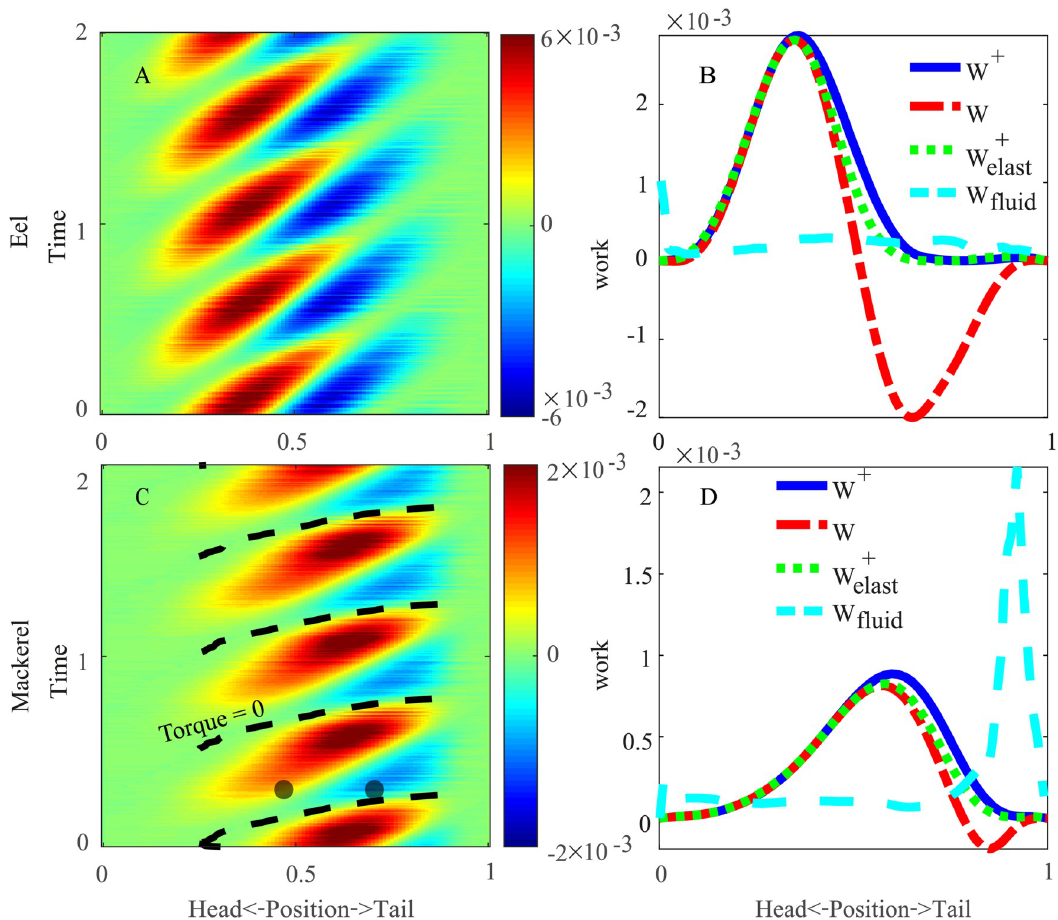
Fig 5. Internal power ( P ( s , t )) distribution for the eel (A) and the mackerel (C) and the work done over a cycle by muscles T along the bodies of the eel (B) and the mackerel (D). The dashed line in (C) indicates the zero-crossing of the torque in the mackerel (Fig 4B). The two black dots in (C) indicate an example time instant when two points on the body have the opposite sign of power but the same sign of torque. The solid blue lines in (B & D) represent the work by integrating only the positive values in (A & C), and the dashed-dotted red lines represent the work ( W ) by integrating both positive and negative values. The dotted green lines represent the positive work W + when body elasticity is considered (Fig 7B & 7D). The cyan dashed lines represent the work done to the fluid by the integration of P F ( s , t